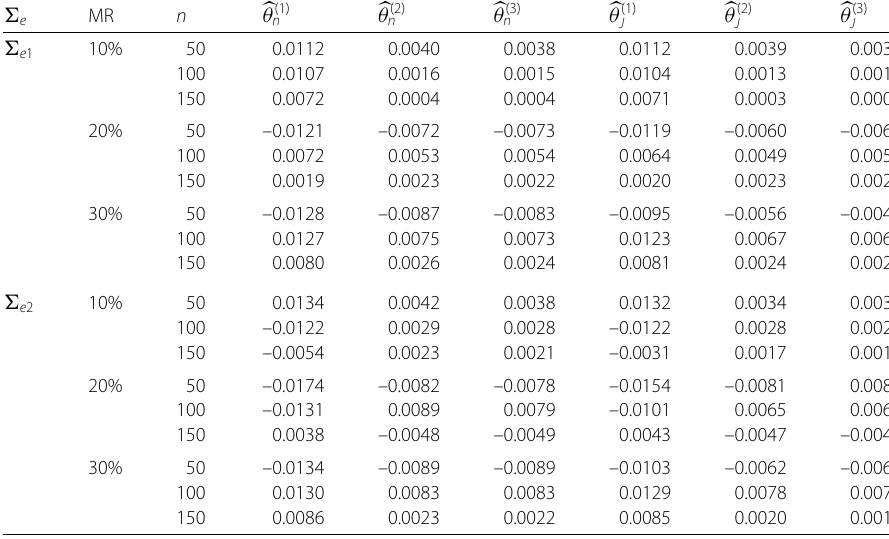
(cid:16) θ ( k ) (cid:16) θ ( k ) with different sample sizes and MRs n and J